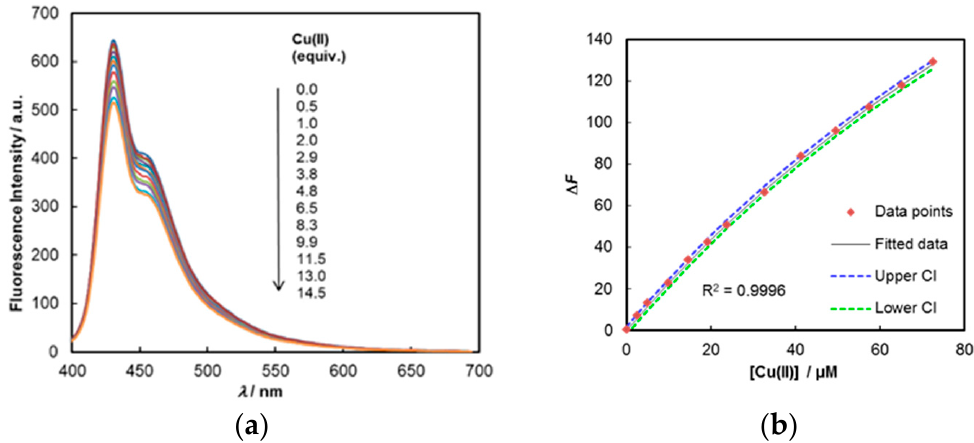
Figure 6. ( a ) Emission spectra of polymer 4 (5.0 × 10 − 6 M in CH 3 CN) upon addition of increasing amounts (up to 14.5 eq.) of Cu(ClO 4 ) 2 ( λ exc = 380 nm); ( b ) Binding isotherm for the fluorimetric titration of 4 with Cu(II) along with the fitted curve and confidence intervals.